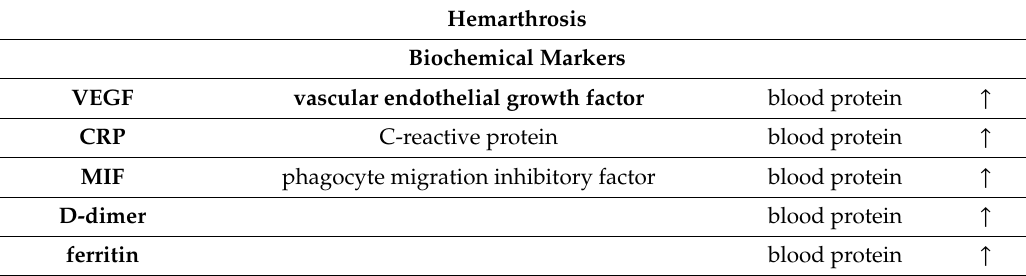
Table 2. Markers related to hemarthrosis stage and their